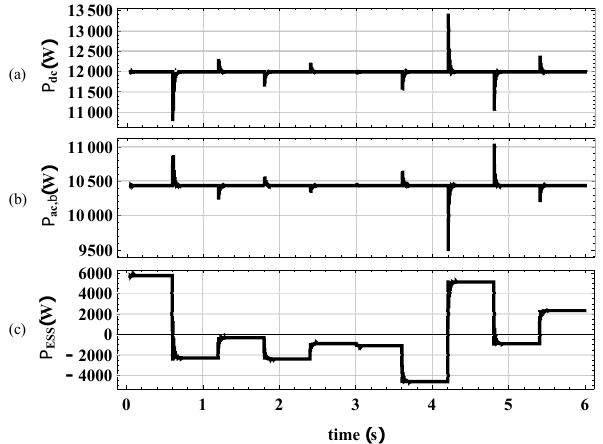
Figure 8. ( a ) power injected into inverter dc port P dc , ( b ) load ac real power P ac , b and ( c ) ESS power injection.